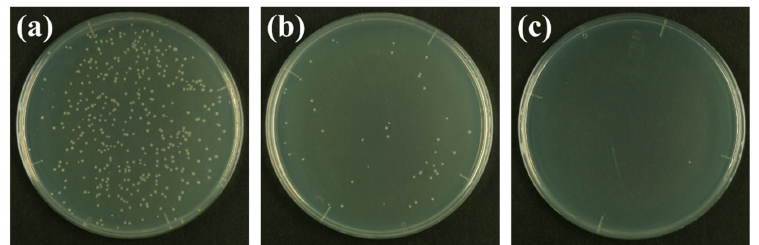
Figure 2. Results of the disinfection for E. coli. ( a ) Control plate (0 mJ / cm 2 DUV dose), ( b ) plate disinfected by 1.0 mJ / cm 2 DUV dose, and ( c ) plate disinfected by 6.0 mJ / cm 2 DUV dose. The number of colonies counted were 365 ± 51 colony-forming units (CFU) for the control plate ( a ), 55 ± 19 CFU for the 1.0 mJ / cm 2 DUV-dose plate ( b ), and 2.0 ± 0.9 CFU for the 6.0 mJ / cm 2 DUV-dose plate ( c ).